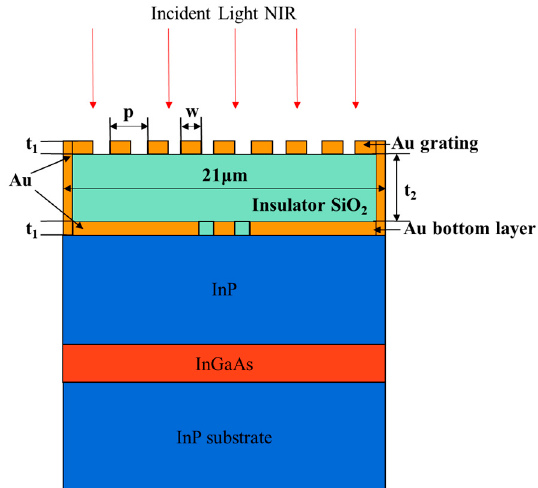
Figure 35. Schematic diagram of InGaAs/InP APDs with metal-insulator-metal (MIM) optical microcavity and cross-sectional of MIM structure.